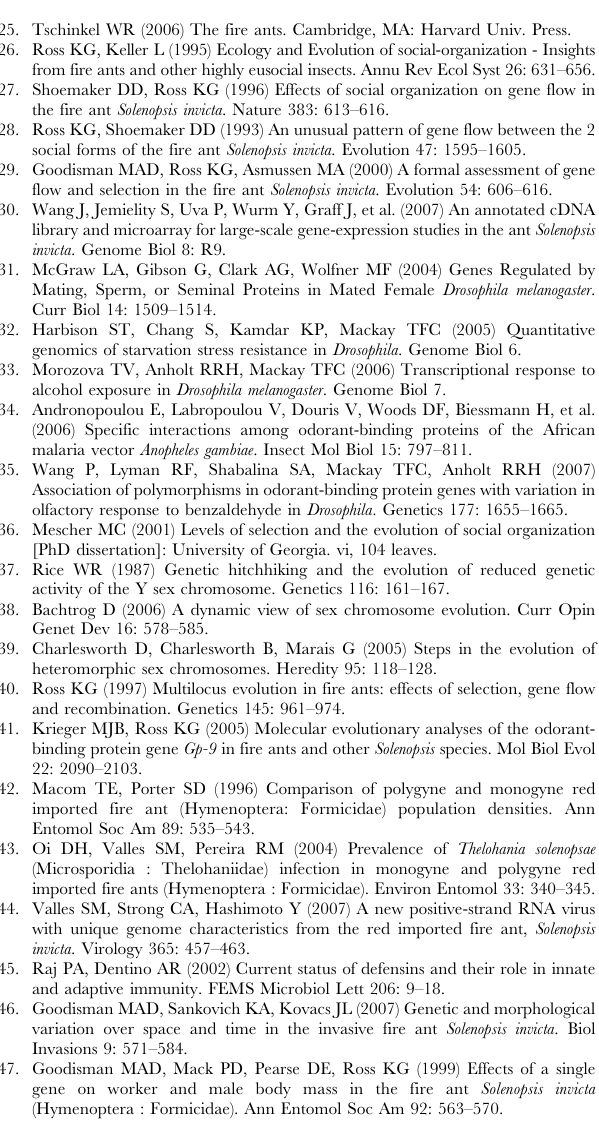
Table S4 BLASTX matches for genes differentially expressed between monogyne and polygyne Gp-9 BB workers.